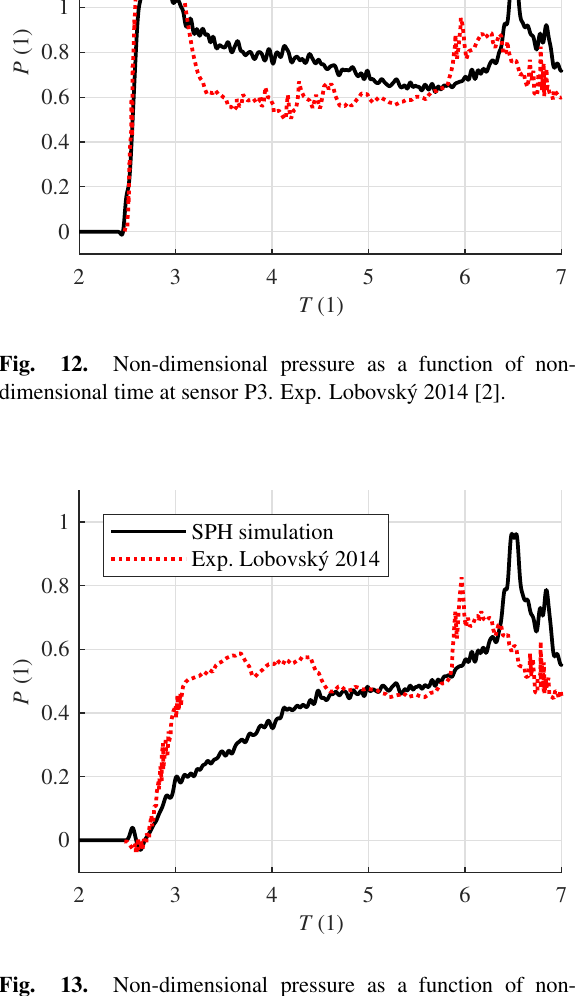
Fig. 13. Non-dimensional pressure as a function of non- dimensional time at sensor P4. Exp. Lobovský 2014